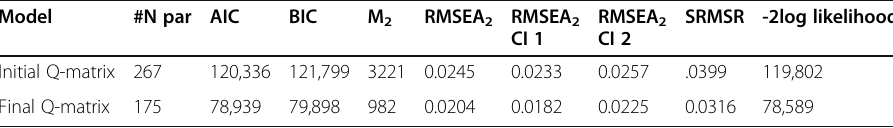
Table 1 Relative and absolute fit indices for initial and final Q-matrices